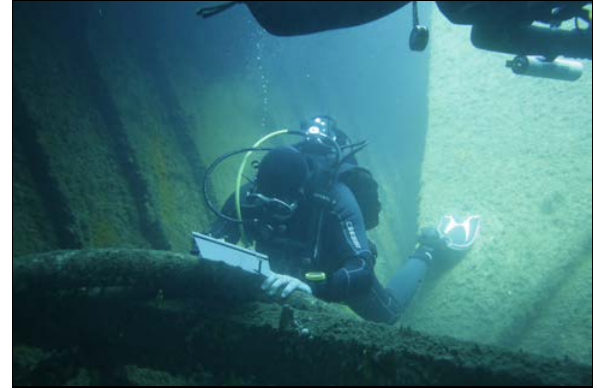
Figure 4. During the site investigation